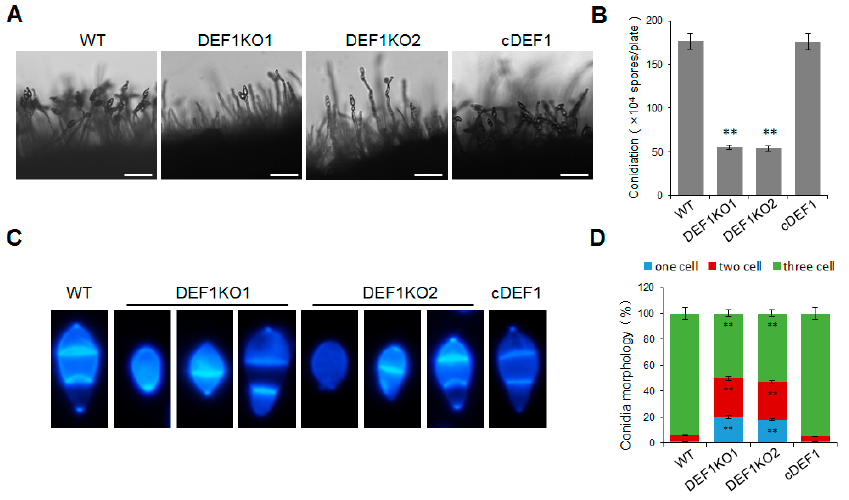
Figure 3. Deletion of Def1 affects conidium formation in M. oryzae . ( A ) Conidiophore of different strains grown on OTA plates were observed under light microscopy. Bar = 50 µ m. ( B ) Conidiation of different strains. Conidia on per OTA plates were washed with 30 mL water and counted using a hemocytometer. Significant differences are labelled with asterisks (**, p < 0.01). ( C ) Conidia morphology of different strains stained by CFW. ( D ) Percentage of conidia with different septum numbers. For each strain, at least 100 conidia were counted. Significant differences are labelled with asterisks (**, p < 0.01). WT, wild type; DEF1KO1 and DEF1KO2, two independent def1 knock out mutants; cDEF1, complementary